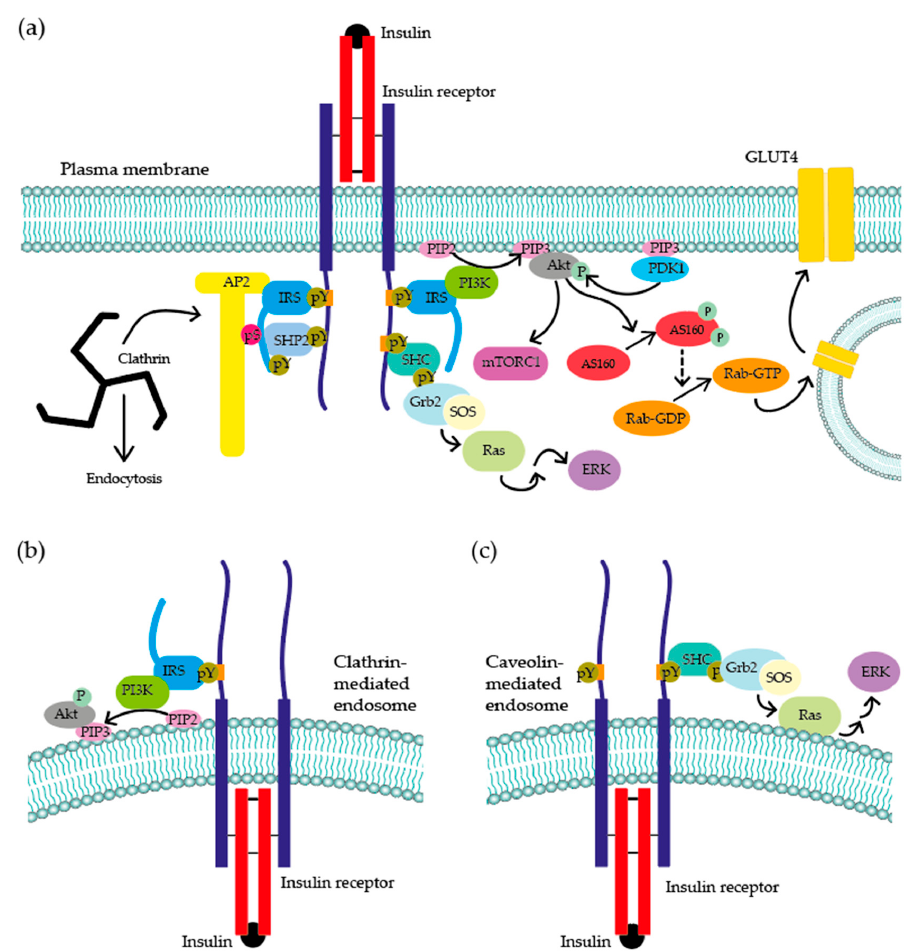
Figure 1. Signalling cascade initiated by insulin binding to the insulin receptor (INSR). ( a ) After insulin binding, receptors aggregate, and autophosphorylation occurs on multiple tyrosine residues, attracting the adaptor protein SHC, which becomes phosphorylated, leading to the activation of the Ras/RAF/MEK/ERK pathway. INSR phosphorylation at Y960 recruits insulin receptor substrate 1 (IRS1), phosphorylating it on Y612, Y632 and Y662. Y612 and Y632 phosphorylation are responsible for the recruitment and activation of PI3K, which leads to Akt activation and, ultimately, to GLUT4 translocation to the plasma membrane in those cells where it is expressed. IRS-1 tyrosine phosphorylation also recruits activated ERK, which causes IRS1 serine phosphorylation, attracting the phosphatase SHP2 and resulting in IRS-1 tyrosine dephosphorylation. This promotes IRS1 interaction with AP2, triggering the internalisation of INSR [9,11]. Once internalised, receptor-mediated signalling is still maintained. Indeed, in the case of clathrin-mediated endocytosis ( b ), up to 50% of insulin-stimulated PI3K activity is generated from internalised receptors [6]. However, ( c ) in cells where INSR is internalised through caveolin-1 (e.g., pancreatic β -cells), ERK activation is enhanced [7]. This indicates that, depending on the type of endocytosis and endosomes localisation, there could be separate insulin-induced activation